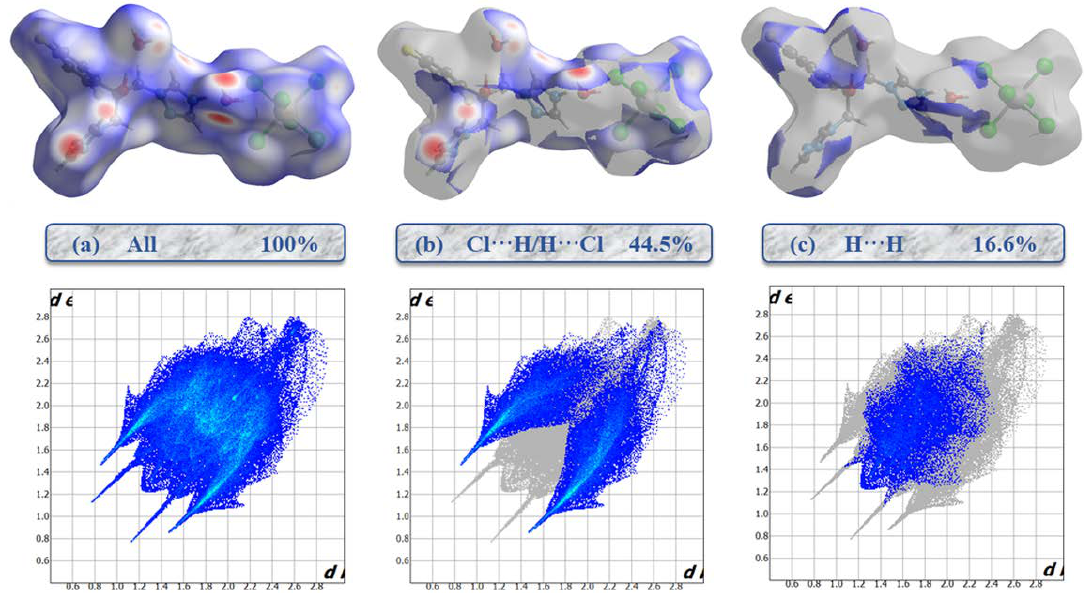
Figure 5. Two-dimensional fingerprint plots order with a d norm view of ( a ) All (100%), ( b ) Cl · · · H/H · · · Cl (44.5%) and ( c ) H · · · H (16.6%) contacts in (H2Fluconazole).SnCl 6 .2H 2 O.